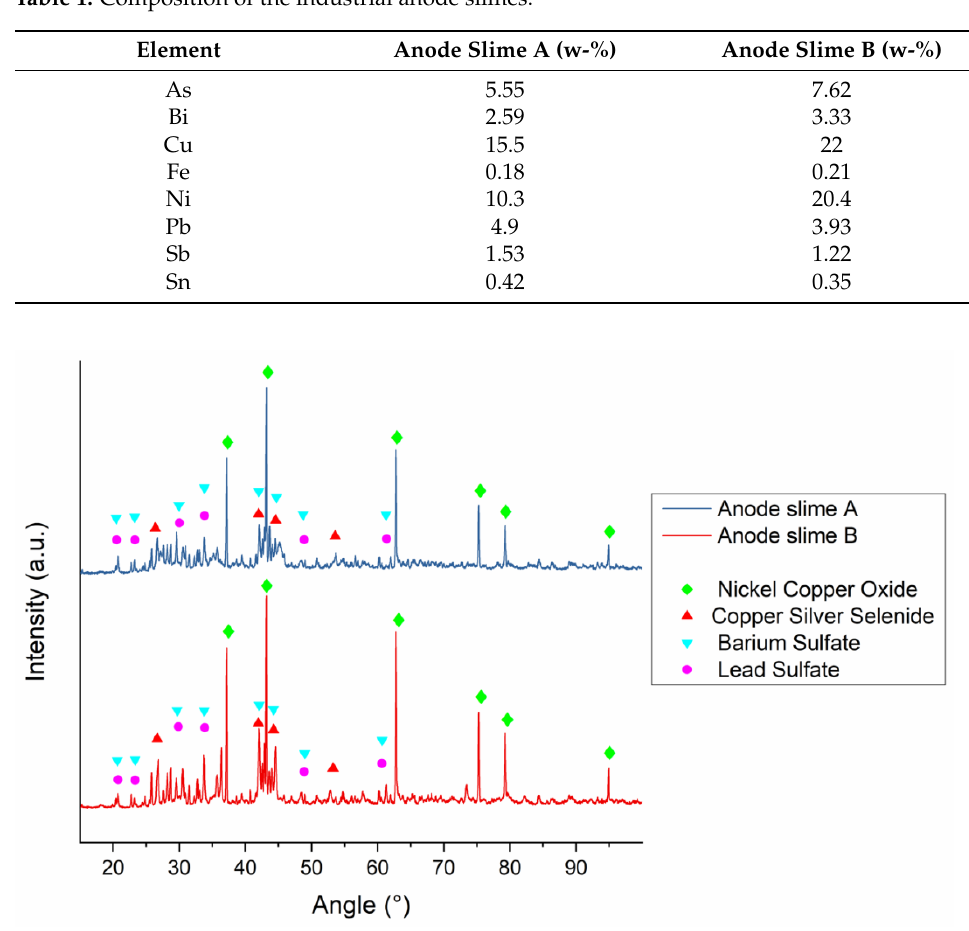
Figure 1. XRD spectra of the industrial anode slimes. Major components of the slimes are marked in the spectra. In addition, slime A contains antimony copper and copper telluride, and slime B contains also copper selenide.